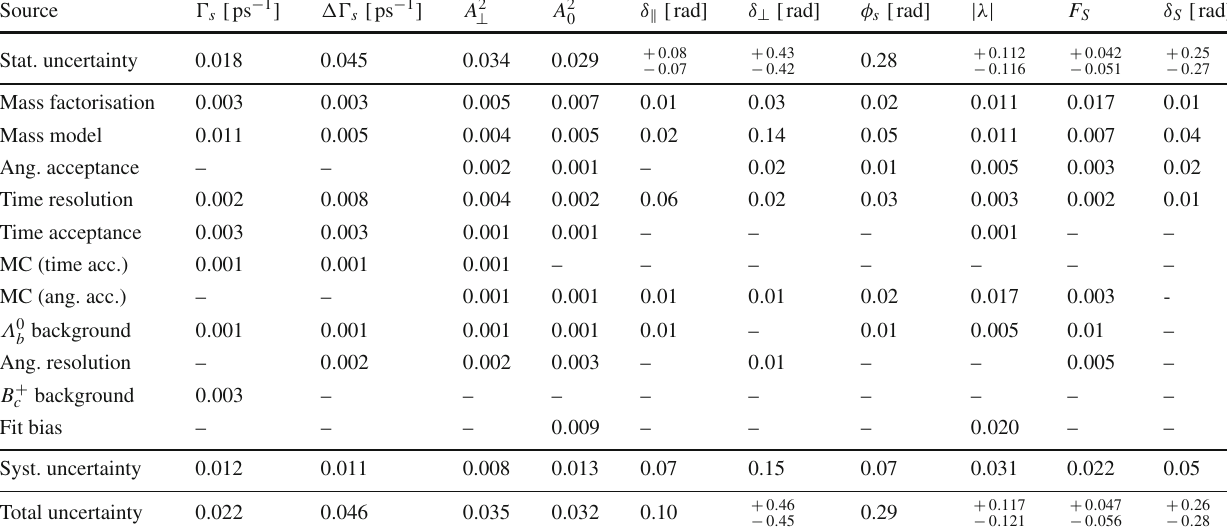
Table 4 Statistical and systematic uncertainties. A dash corresponds to systematic uncertainties that are negligible. Systematic uncertainties from different sources are added in quadrature Source